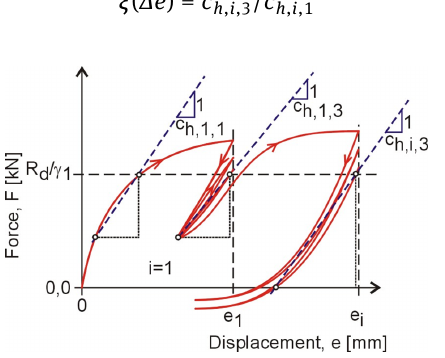
Figure 12: Method of prediction c h , i ,1 and c h , i ,3 values (flexibilities in the first and third cycle at the same displacement range ∆e ) as a part of evaluation of the ξ ( ∆e ) .